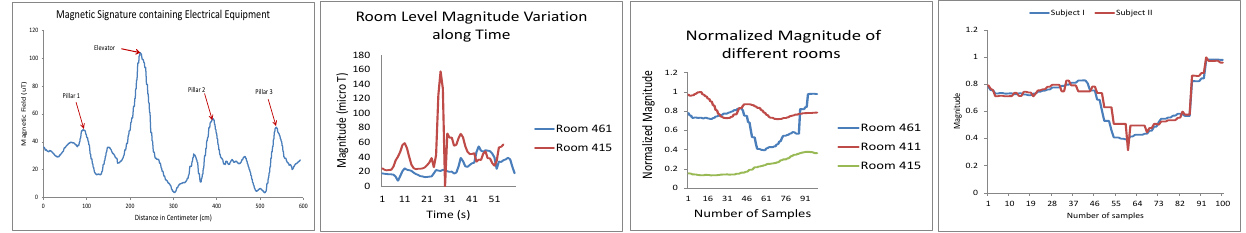
Figure 7: Magnetic signature variation along time for two rooms.